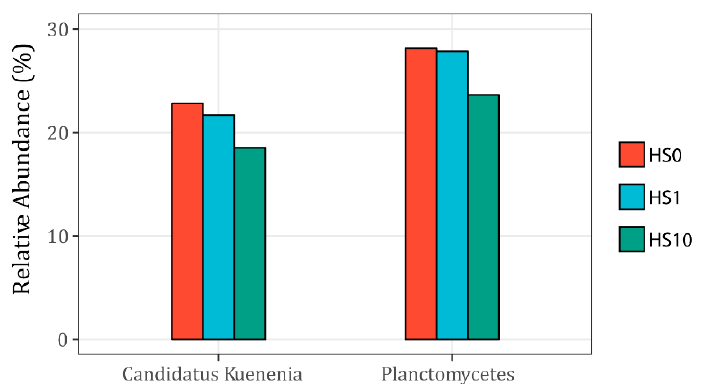
Figure 2. Relative abundance of the anammox community under different humic substance concentrations. HS0, HS1 and HS10 indicate 0, 1 and 10 mg · L − 1 humic substances, respectively.